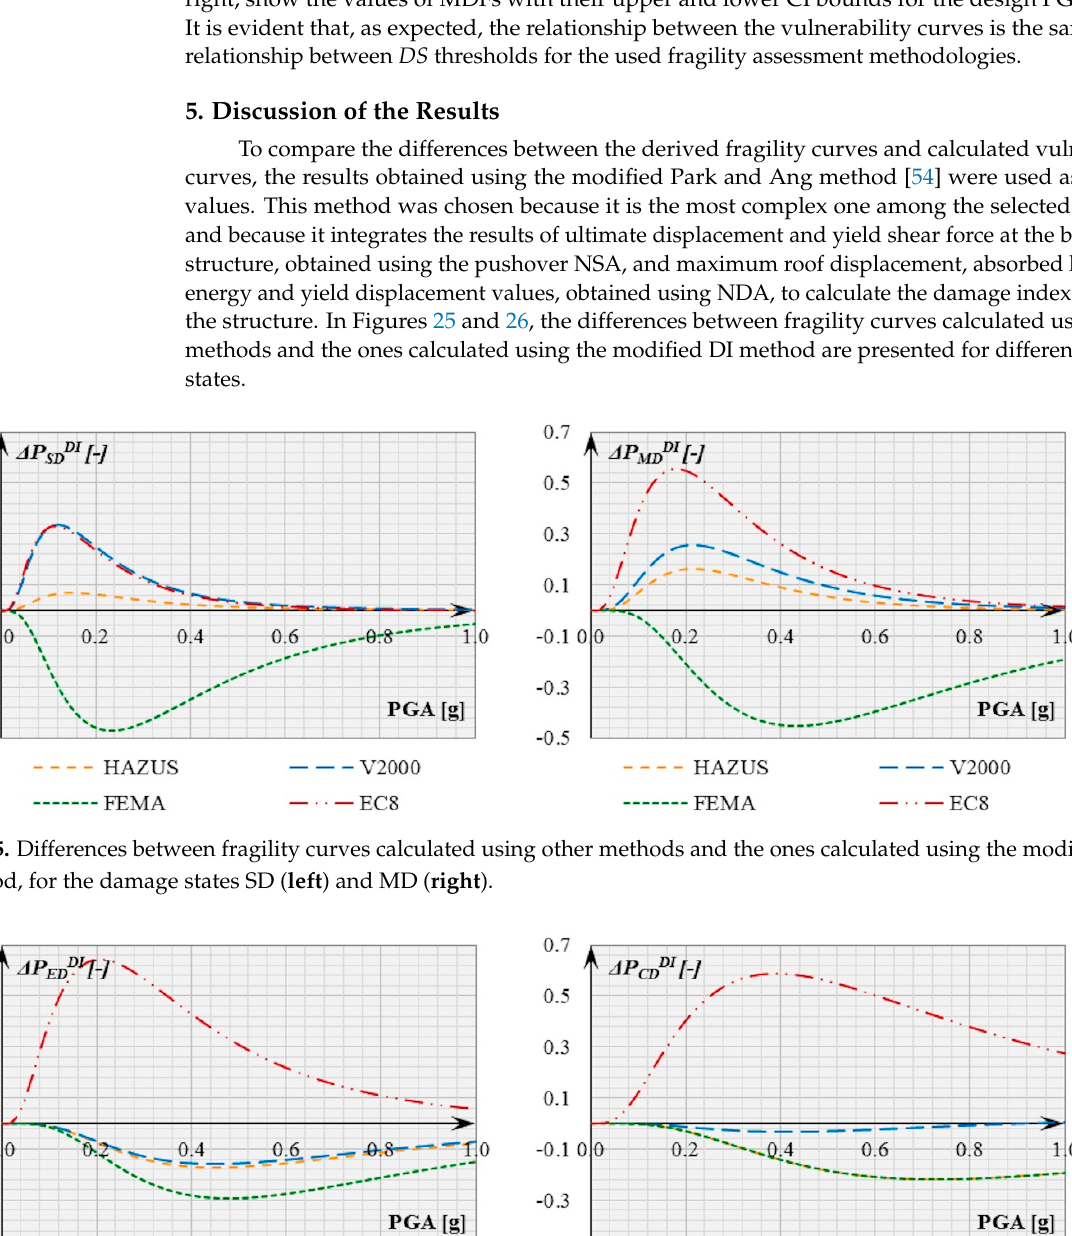
Figure 27. Differences between vulnerability curves calculated using other methods and the ones calculated using the modified DI method. The differences for the value of the design PGA = 0.2 g compared to the modified damage index are shown in Table 4. Table 4. The differences for the value of the design PGA compared to the modified DI. Difference